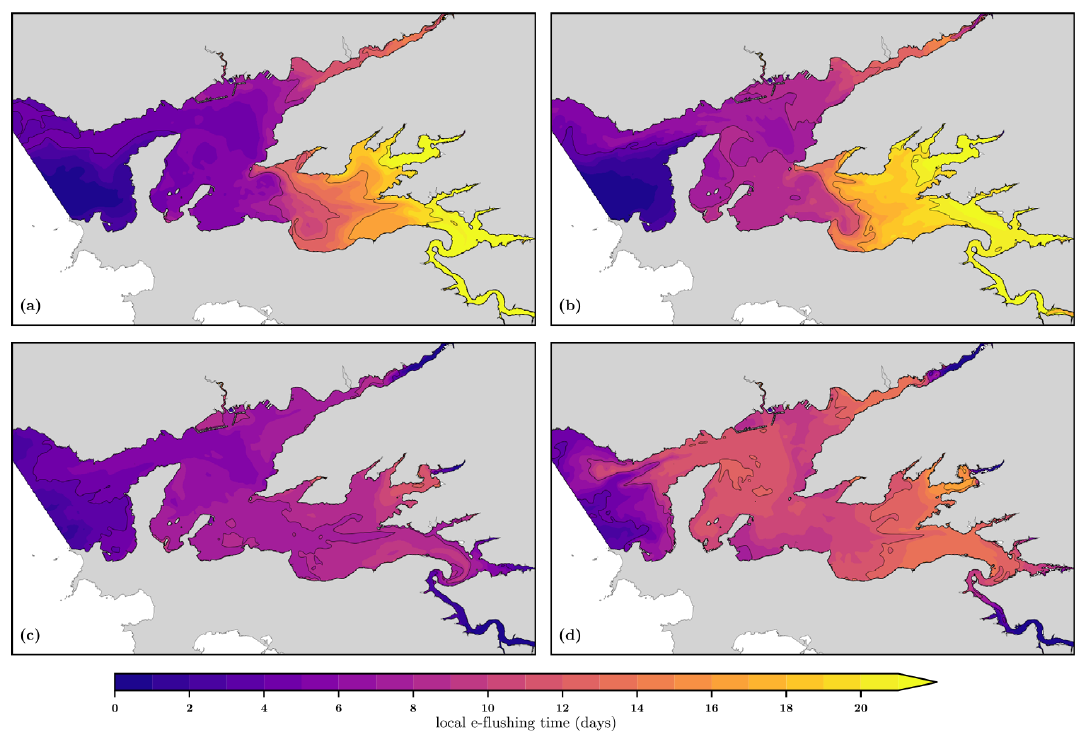
Figure 9. Local e -folding flushing time estimated for spring (a) and neap (b) tides in low-flow conditions and for spring (c) and neap (d) tides for flood conditions. Coastline source: